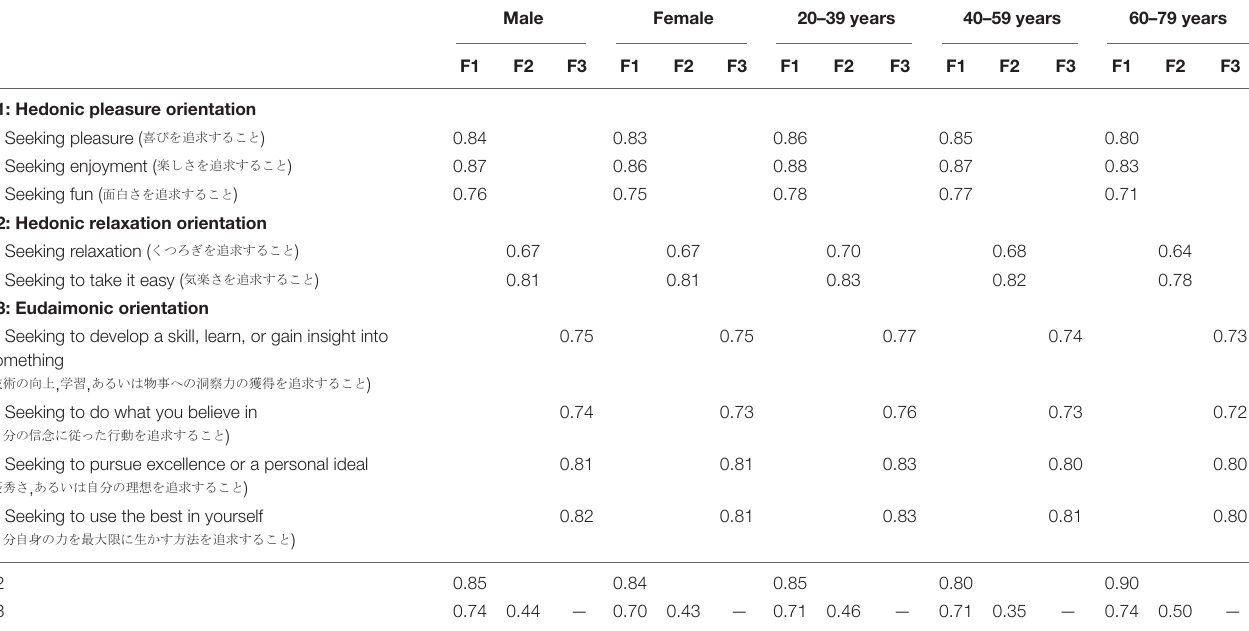
The Japanese translations are indicated in